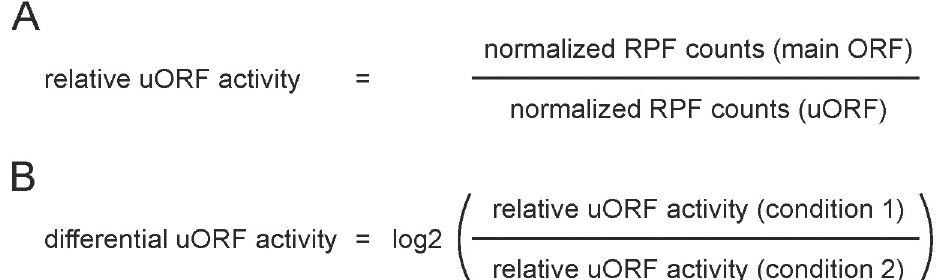
Fig 2. Calculation of relative uORF translation. (A) Relative uORF translation is determined for each experimental condition as ratio of the normalized ribosome protected fragment (RPF) counts of a specific main ORF relative the normalized RPF counts of the respective uORF. (B) Stimulus-dependent, differential uORF translation is then calculated as the log2 fold change of the ratio of the relative uORF translation of treatment (condition 1) vs. control (condition